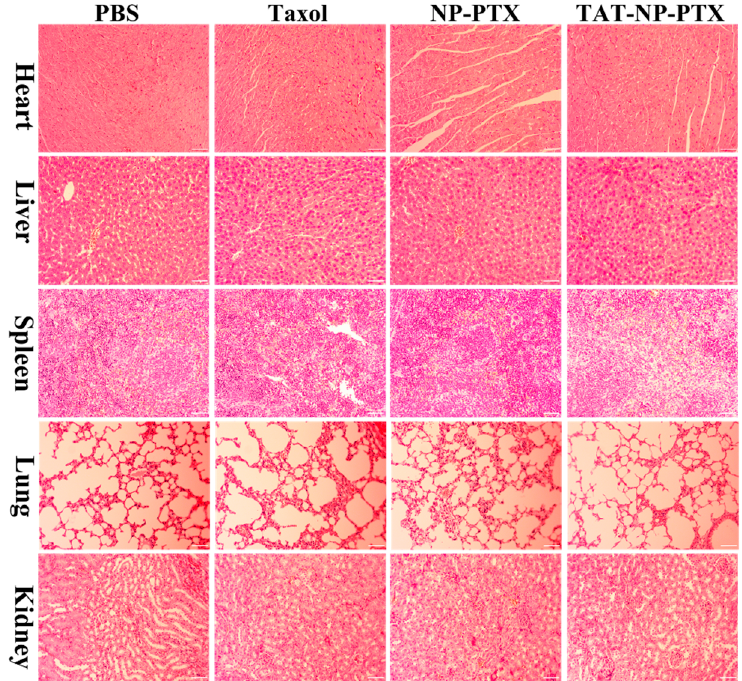
Figure 6. Biosafety analysis of major organs treated with PBS, Taxol, NP-PTX, TAT-NP-PTX at the equivalent PTX dose of 10 mg/kg by H&E staining. Bar = 100 μ m.